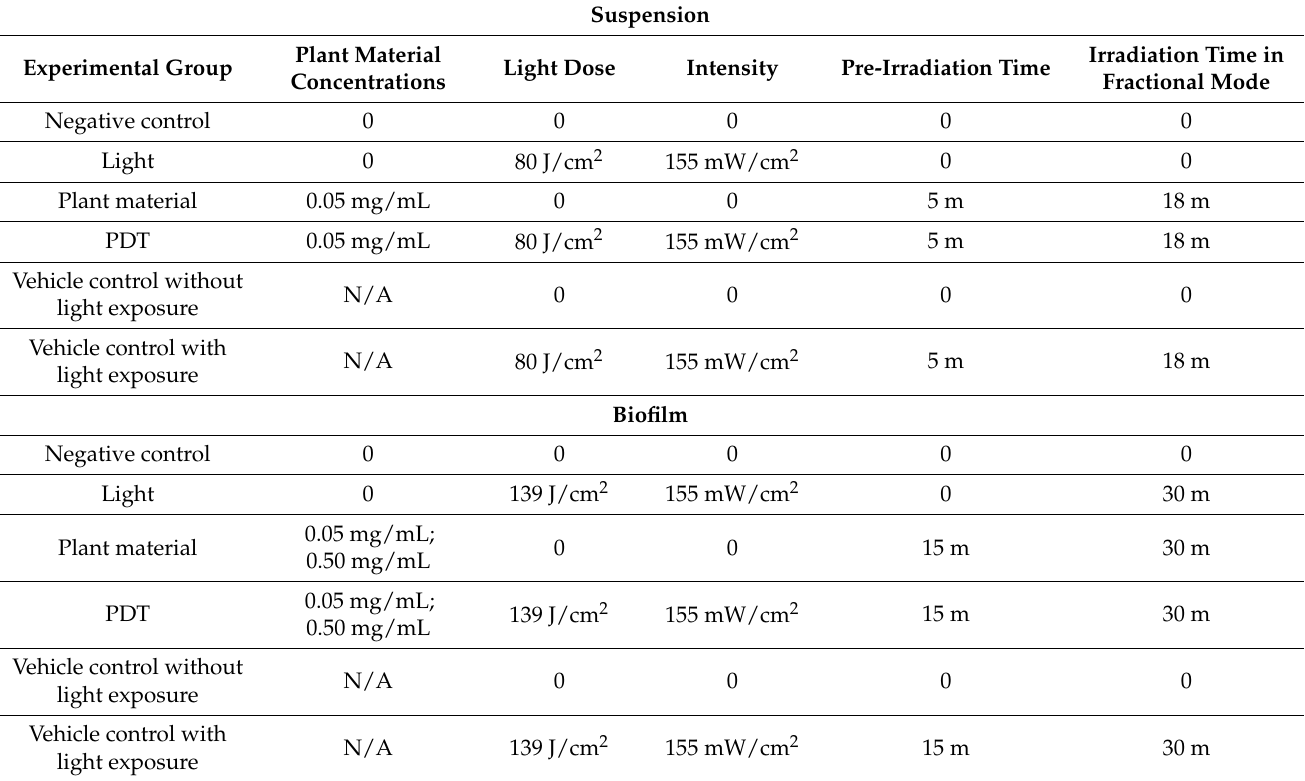
Table 1. Experimental parameters of aPDT using microbial suspensions and